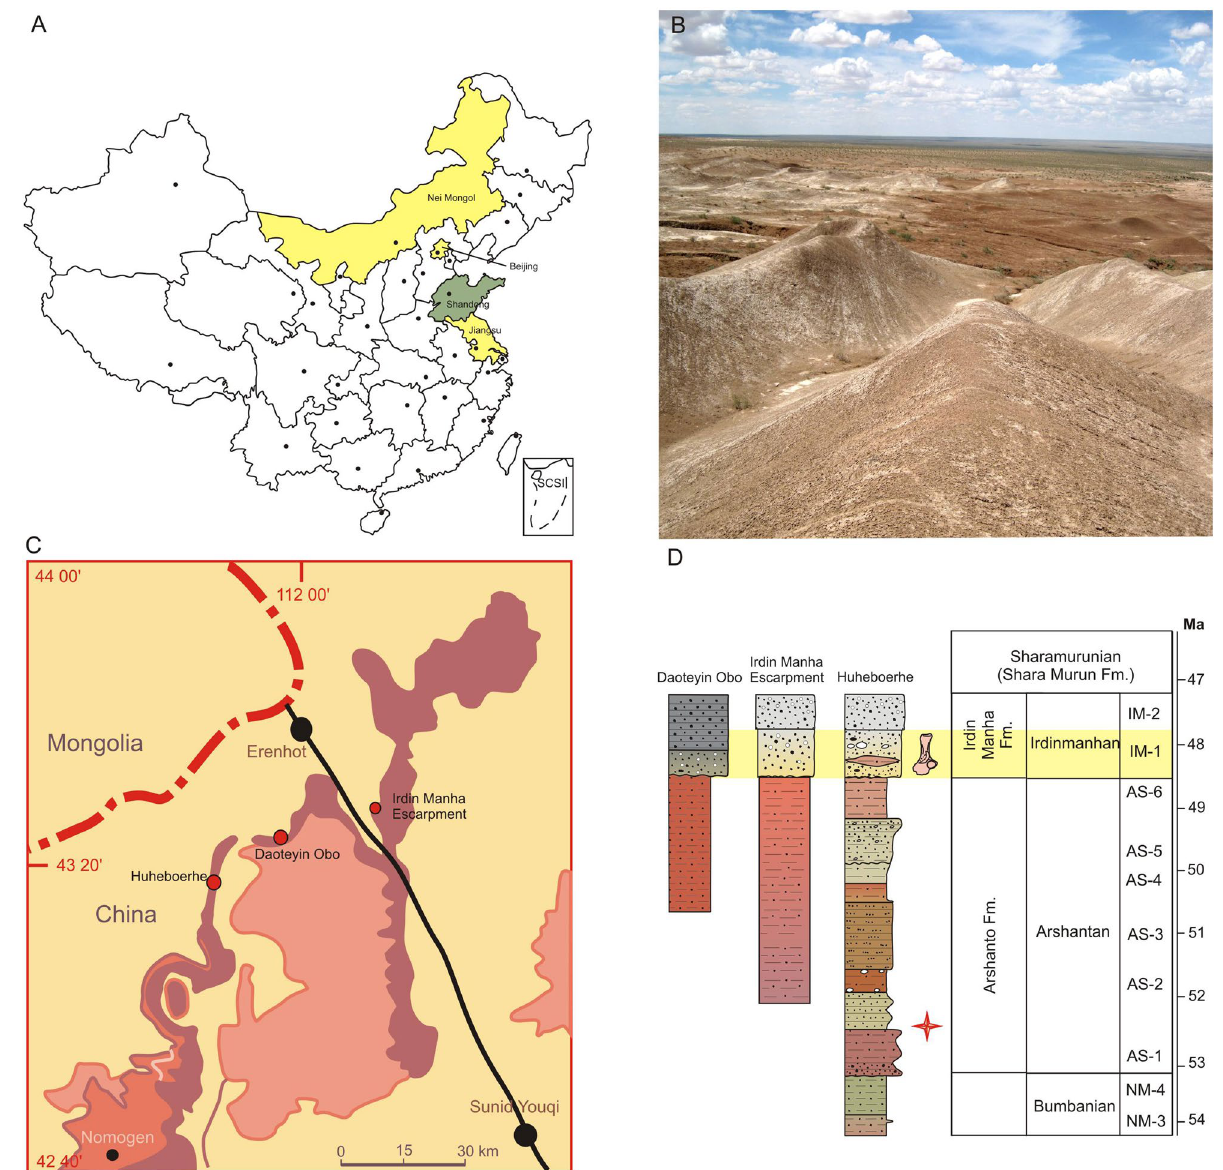
Figure 1. Stratigraphic and geographic distribution of Ischyromyidae in China. ( A ) map of ischyromyid findings in China; yellow denotes Irdinmanhan findings in a province, green denotes older (?Bumbanian) findings; ( B ) panoramic view of Huheboerhe area; ( C ) detailed map of studied sites in the Erlian Basin; ( D ) stratigraphy of studied localities in the Erlian Basin, Nei Mongol, China; Irdinmanhan strata marked in yellow. (Maps and stratigraphic section created in Corel Draw X4 (v.14.0.0.567) by Łucja Fostowicz-Frelik; photograph taken by Łucja